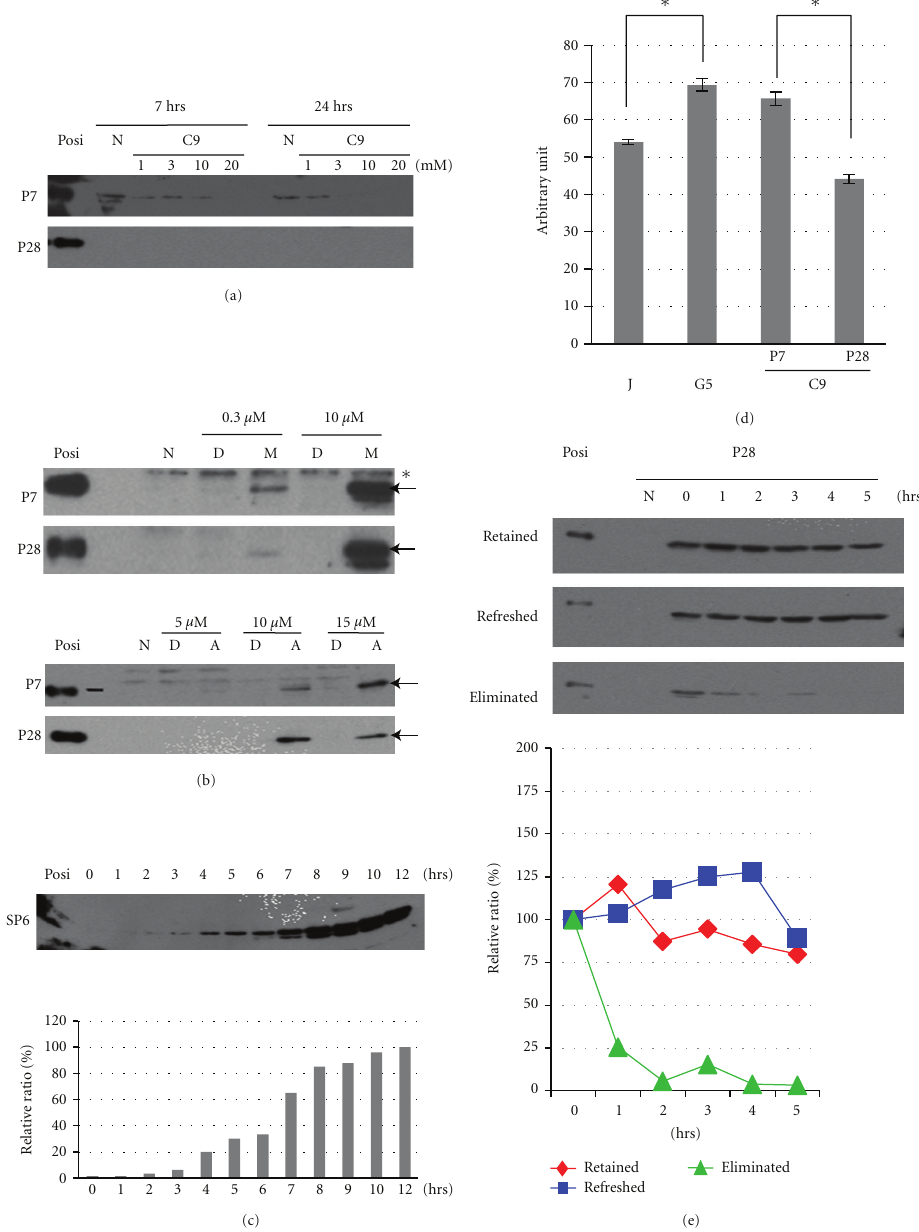
Figure 2: E ff ects of protease inhibitors on SP6 expression level in C9 cells. (a) Dose-dependent e ff ects of the lysosomal inhibitor, NH 4 Cl, on SP6 expression in C9 cells. The SP6 expression level was evaluated by WB. Posi: positive control; N: no treatment. (b) Dose-dependent e ff ects of MG132 on SP6 expression in C9 cells. Upper panel: the cells were treated with MG132 (M) or DMSO (D) as a control (vehicle alone) for 7h. Lower panel: cells were treated with ALLN (A) or DMSO (D) for 7h. Posi: positive control; N: no treatment; arrow: SP6; asterisk: nonspecific band. (c) Time course of the e ff ects of MG132 treatment on SP6 induction in C9 cells. C9 cells at P28 were treated with 10 µ M MG132 during the indicated time. Upper panel: SP6 expression analysed by WB; Posi: positive control. Lower panel: Relative levels of signal intensity of WB. Each SP6 level was shown as the relative level compared with the signal detected at 12 h (100%). (d) 20S proteasome activity in G5 and C9 cells (P7 and P28). J: Jurkat cells (positive control). The brackets show the significant di ff erence demonstrated by Student’s t -test ( n = 3, ∗ P < 0 . 01). (e) Half-life analysis of SP6 in C9 cells at P28 determined by blocking de novo protein synthesis. C9 cells were pretreated with MG132 for 8 h, and then 10 µ g/mL CHX was added during the indicated time. Upper panel: SP6 expression detected by WB; Retained: no medium change (MG132 was retained) when CHX was added; Refreshed: new medium replaced the old medium, and MG132 was newly added to the culture with CHX; Eliminated: the medium was replaced without MG132, only CHX was added; Posi: positive control; N: untreated C9 cells. Upper panel: relative SP6 expression level ratios. Each signal level was normalized with that at time 0 (100%). Data were reproduced by two independent